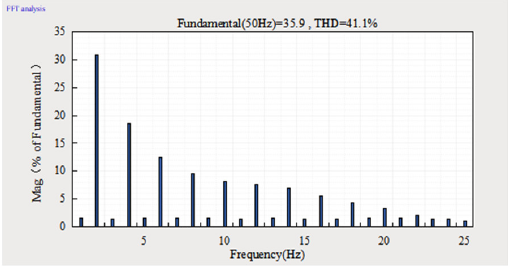
Figure 10. PI control load current, compensation current, and grid current waveforms.